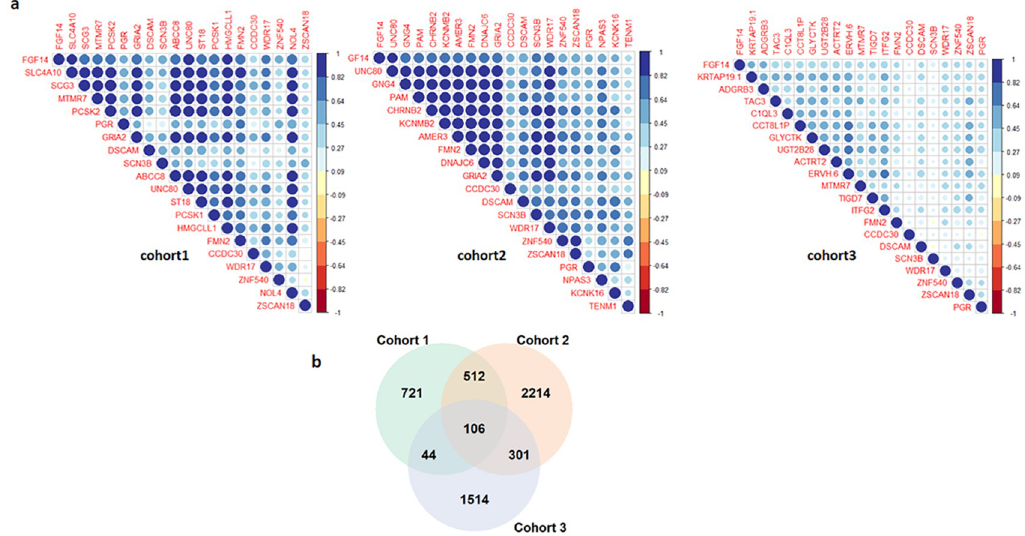
Fig 2. (a) Top positively correlated genes associated with FGF14 at expression level in three independent cohorts of PDAC patients (b) Venn diagram illustrating top positively correlated genes of FGF14 at expression level common among the three independent cohorts of PDAC patients.